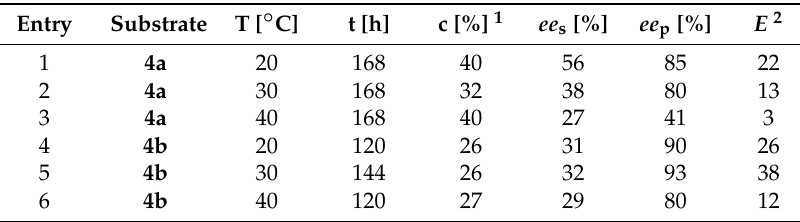
Table 1. Kinetic resolution of allyl esters 4a , b catalyzed by Lecitase ® Ultra-catalyzed hydrolysis at different temperatures. Entry